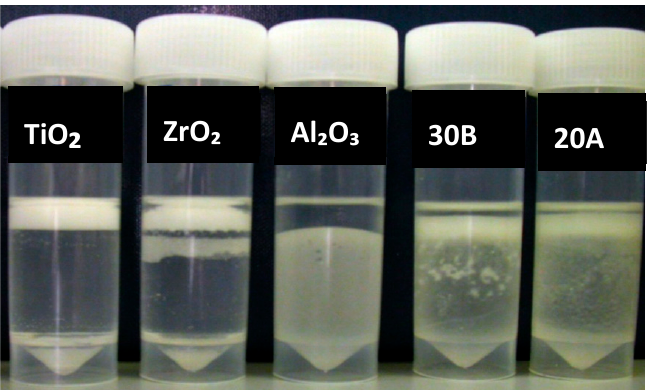
Figure 9. Particles subsequent to silane treatment, method I, mixed with monomer stored for 24 h from left to right; silane treated TiO 2 , ZrO 2 , Al 2 O 3 and nanoclays 30B and 20A. The tube test of Silane-treated particles through method “II” showed that after 1-h storage, TiO 2 , ZrO 2 , Al 2 O 3 , closite 20A and closite 30B were partially suspended in the monomer. Silanated laponite was particularly compatible with MMA (Figure 10). Method III of silane treatment showed a medium degree of compatibility with the monomer after treatment (Figure 11).